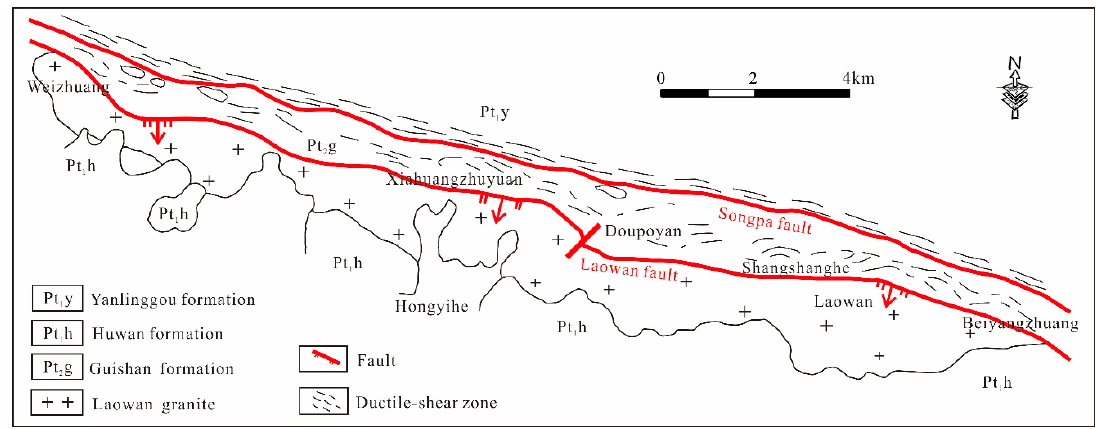
Figure 2. Geological overview map of Laowan deposit, Henan province (modified from 1:2000 geological maps from No.1 Institute of Geology and Exploration, Henan Geology and Exploration Bureau).